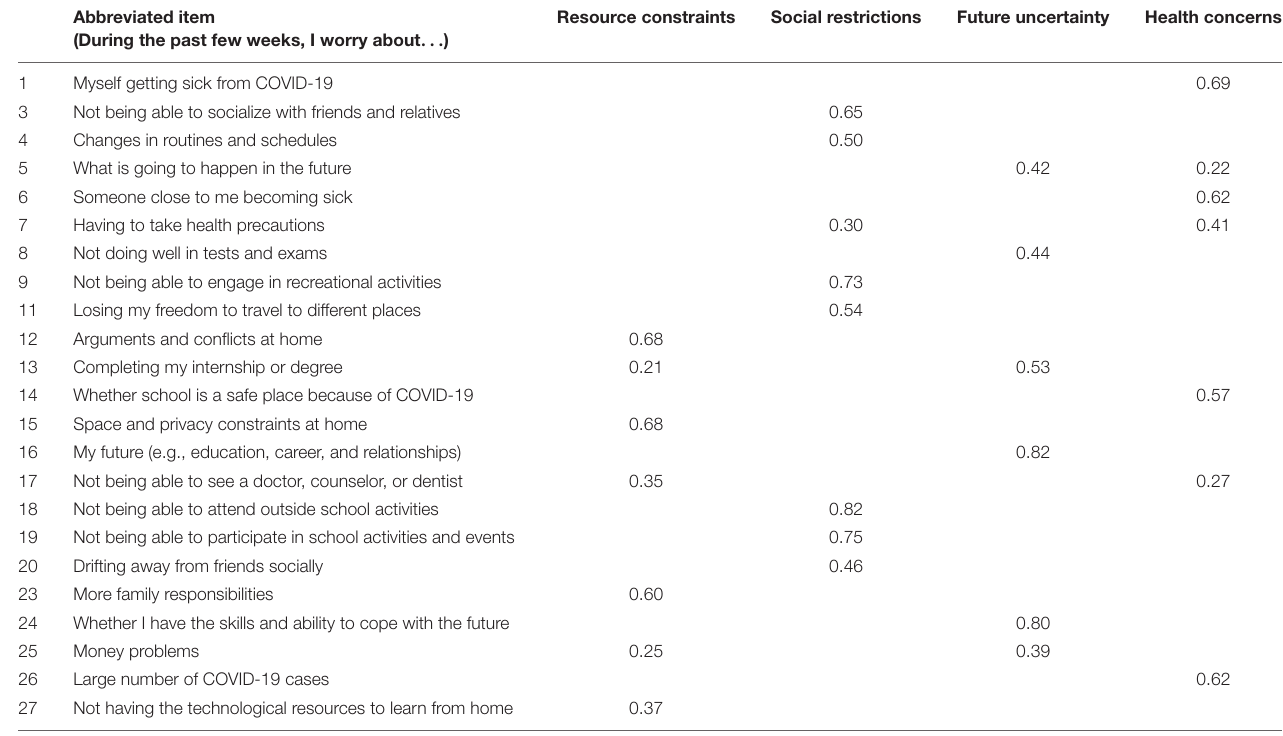
TABLE 2 | Standardized pattern coefficients for the final four-factor solution after excluding Item 2, 10, 21, and 22. Abbreviated item (During the past few weeks, I worry about ...